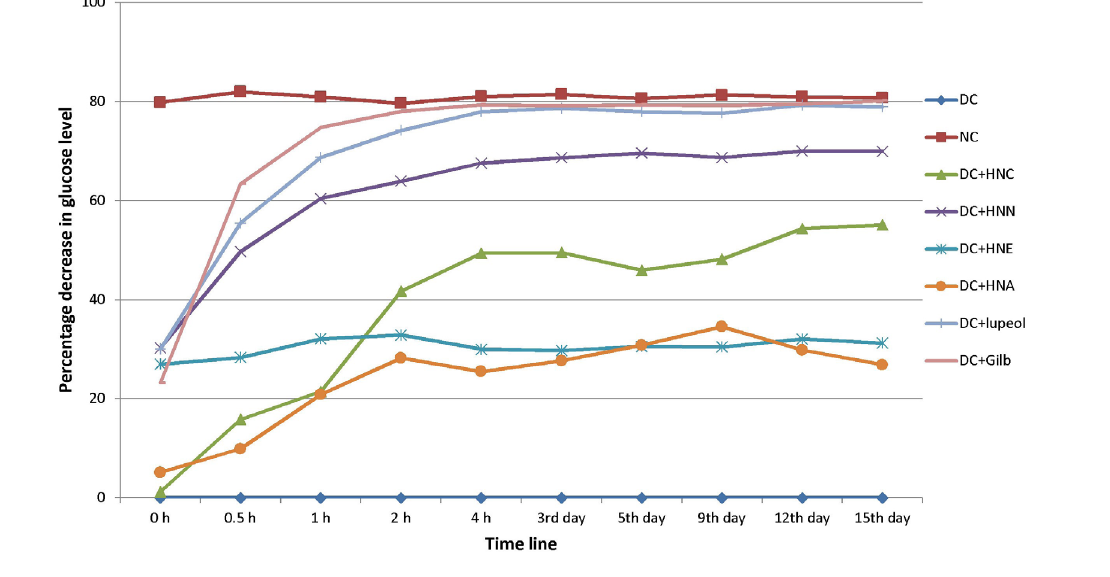
FIGURE 1 - Change (percent) in blood glucose level of alloxan induced diabetic rats on different timeline. Values are significant at *p<0.05 as compared to diabetic control group expressed as means. Where “NC” is normal control, “DC” is diabetic control, “HNC” is H. nepalensis crude extract, “HNN” is H. nepalensis n-hexane fraction, “HNE” is H. nepalensis ethyl acetate fraction, “HNA” is H. nepalensis aqueous fraction and “Gilb” is glibenclamide served as positive